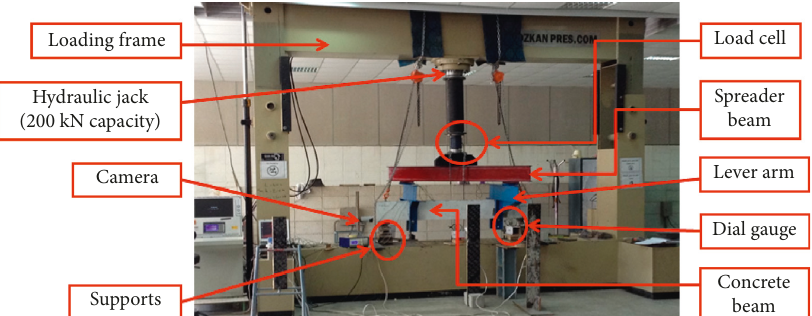
Figure 8: Test setup with the loading frame.